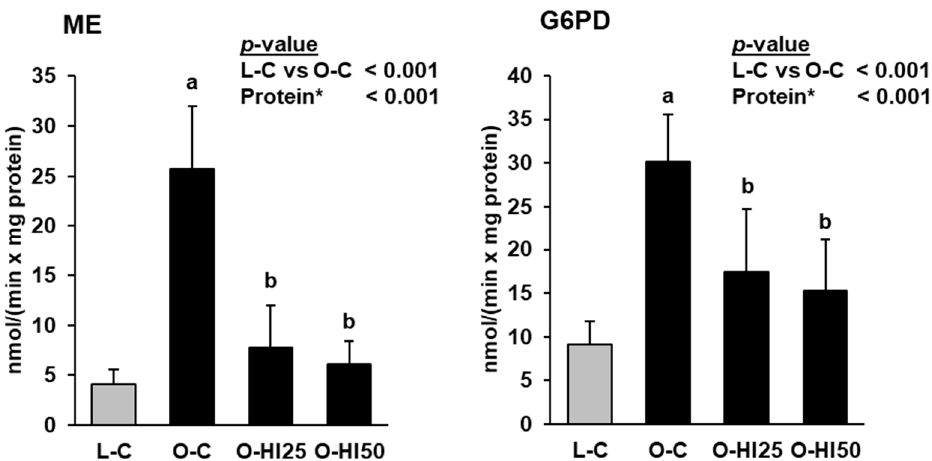
groups: a,b,c Bars without a common letter differ across the obese groups, p < 0.05. Hepatic activities of ME and G6PD were markedly higher in group O-C than in group L-C, but lower in groups O-HI25 and O-HI50 than in group O-C ( p < 0.05, Figure 2).